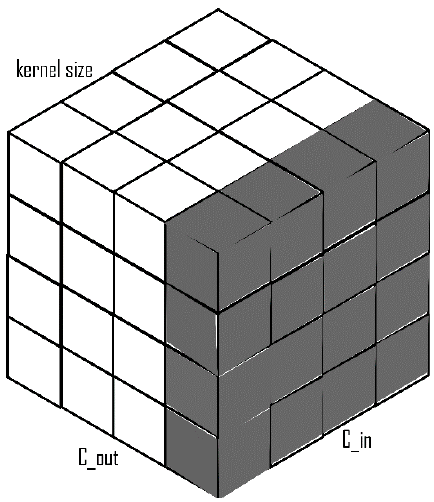
Figure 4. Weight standardization with C_out as the number of output channels, C_in as the number of input channels x kernel size.